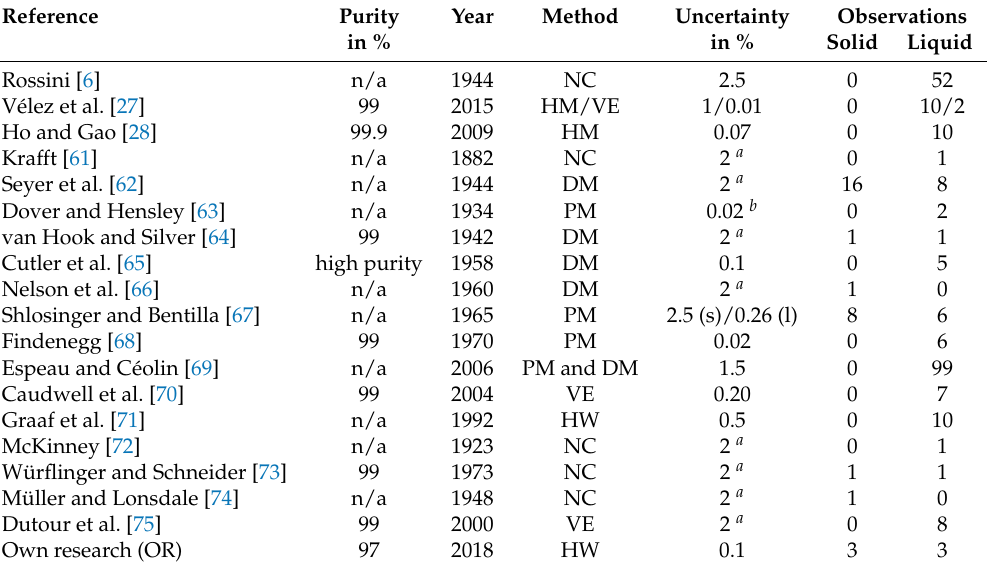
Table 2. Summary of density data from the literature.